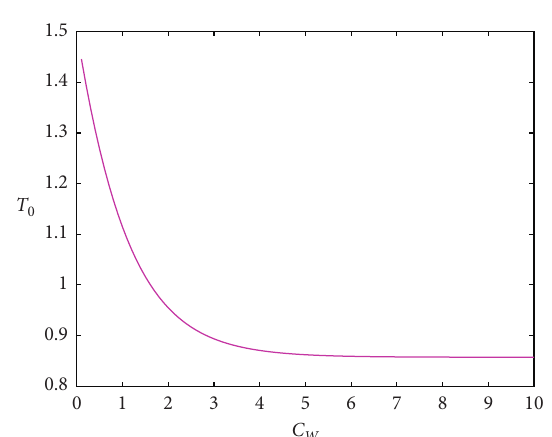
Figure 10: T 0 versus C W in the case where β μ � 1, and τ � 0.005.